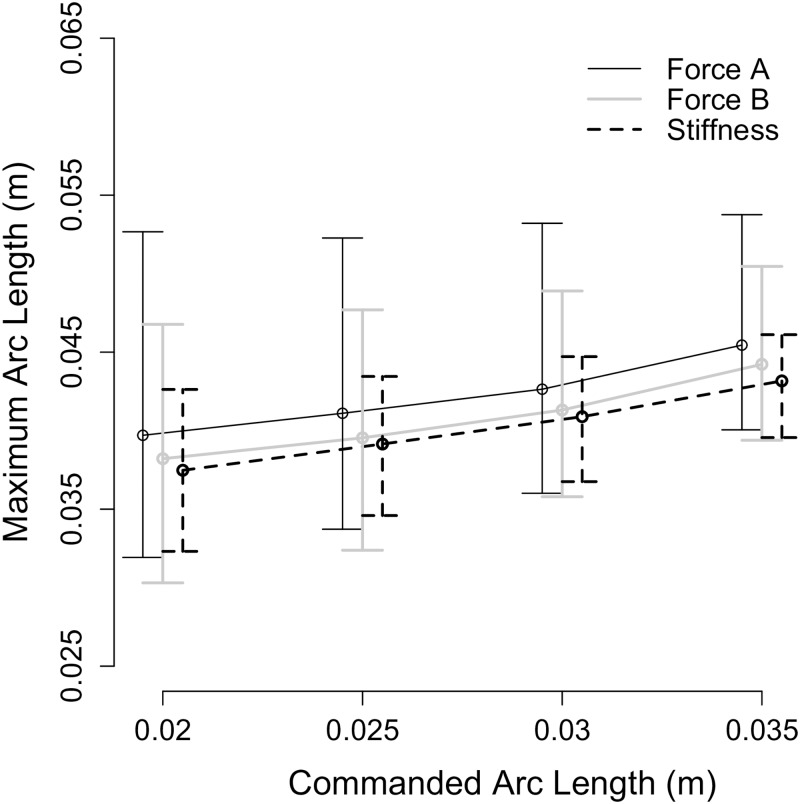
Maximum arc length to which participants’ fingers traveled.Median value (points) and lower and upper quartiles (error bars) of the maximum arc length to which participants’ fingers traveled across all trials for all participants are given as a function of the commanded arc length and stimulus type.